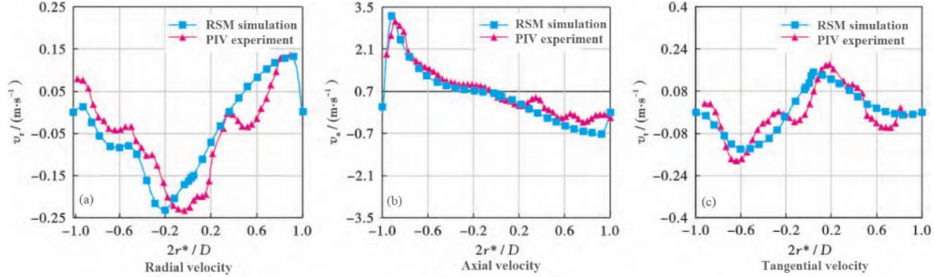
Figure 6. The distribution of velocity of the spiral separator